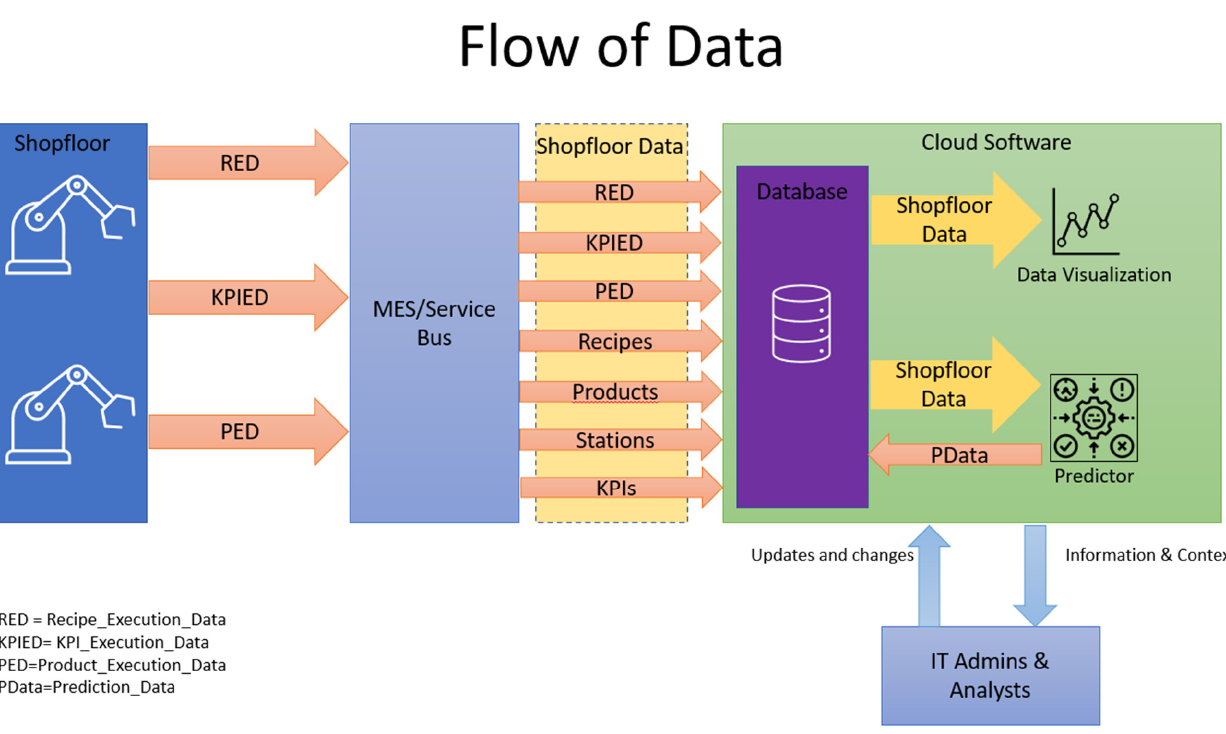
Figure 8. Flow of data from the shopfloor to the cloud software.